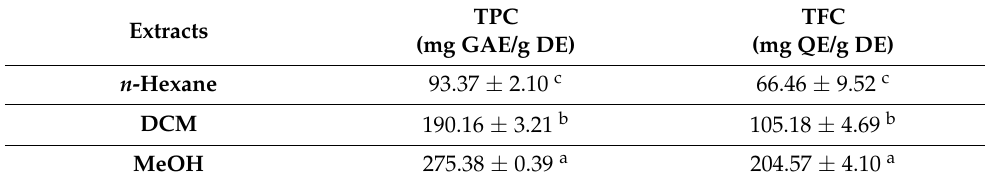
TPC (mg GAE/g DE)